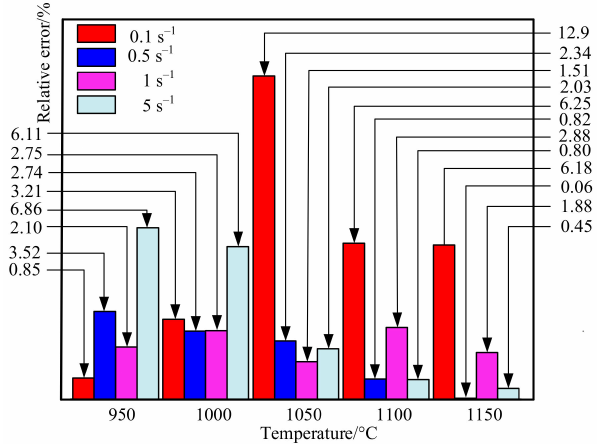
Figure 10. Relative error diagram of X12 steel fracture displacement and sample fracture displacement during